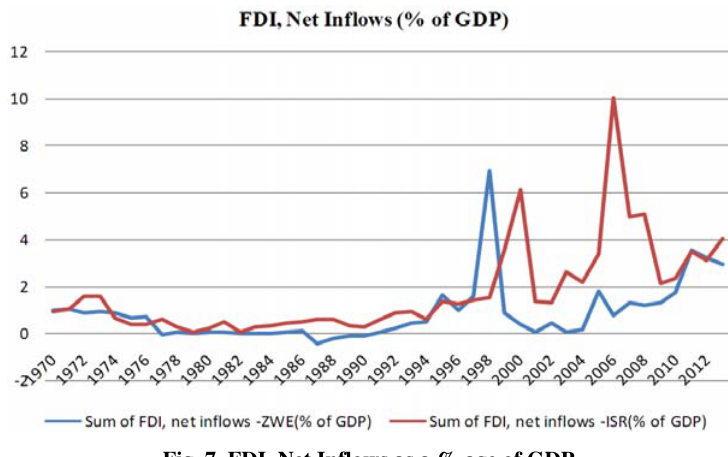
Fig. 7. FDI, Net Inflows as a % age of GDP Source: based on the World Bank (2015) World Development Indicators